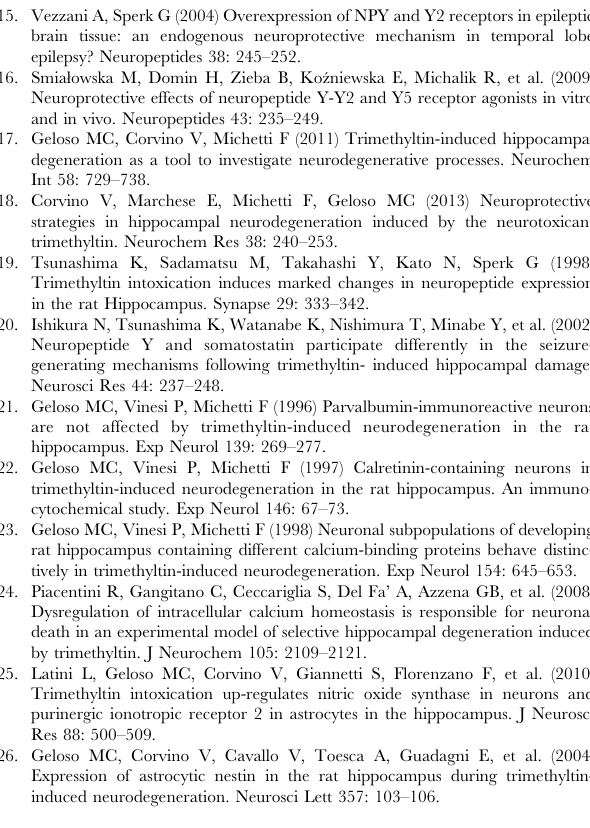
Table S1 Oligonucleotide primer sequences. The table indicates the oligonucleotide primer sequences used in qPCR analysis.